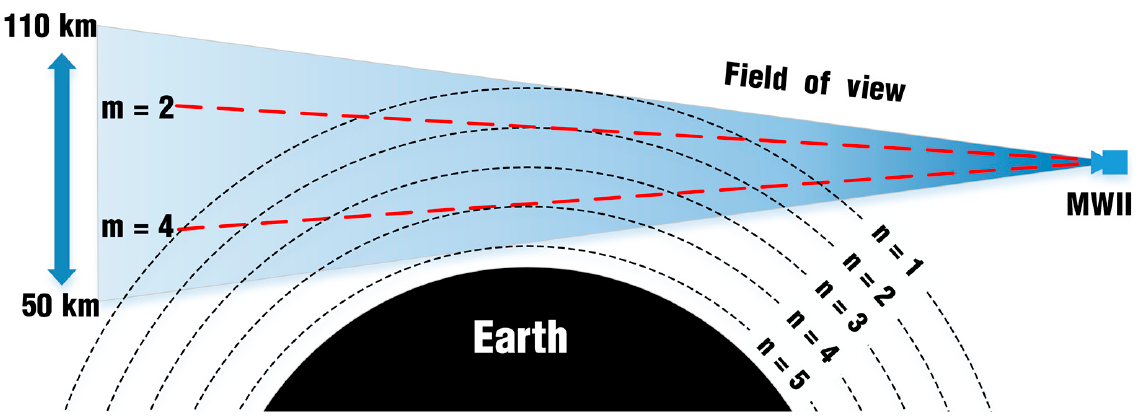
Figure 2. Limb-view observation geometry of the MWII. The red line is the line-of-sight of corre- sponding altitude to the tangent point, and the blue area represents the altitude coverage of MWII. The passive wind measurement interferometer can only obtain the line-of-sight (LOS) wind speed by a single observation from one direction. In order to achieve the vector wind field measurement, it is necessary to observe from at least two different directions, preferably orthogonal. Therefore, the MWII has two nearly orthogonal fields of view (FOV1 and FOV2) to obtain the vector wind field. After FOV1 observes the mesosphere of a specific area, through the movement of the satellite, FOV2 makes a second observation of the same area from a direction orthogonal to the first observation after about 10 min. The orthogonality of the two observations is guaranteed by the observation geometry design without the need for satellite attitude